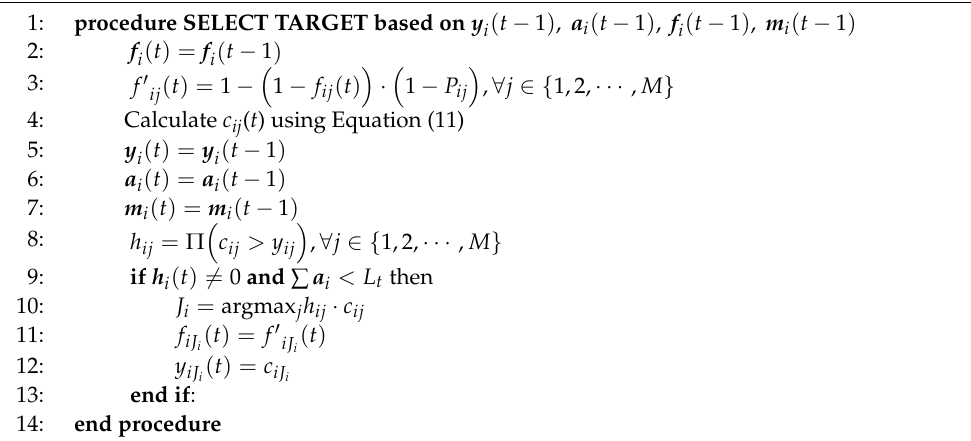
Algorithm 1: The MTCBAA auction phase of an agent r i at an iteration